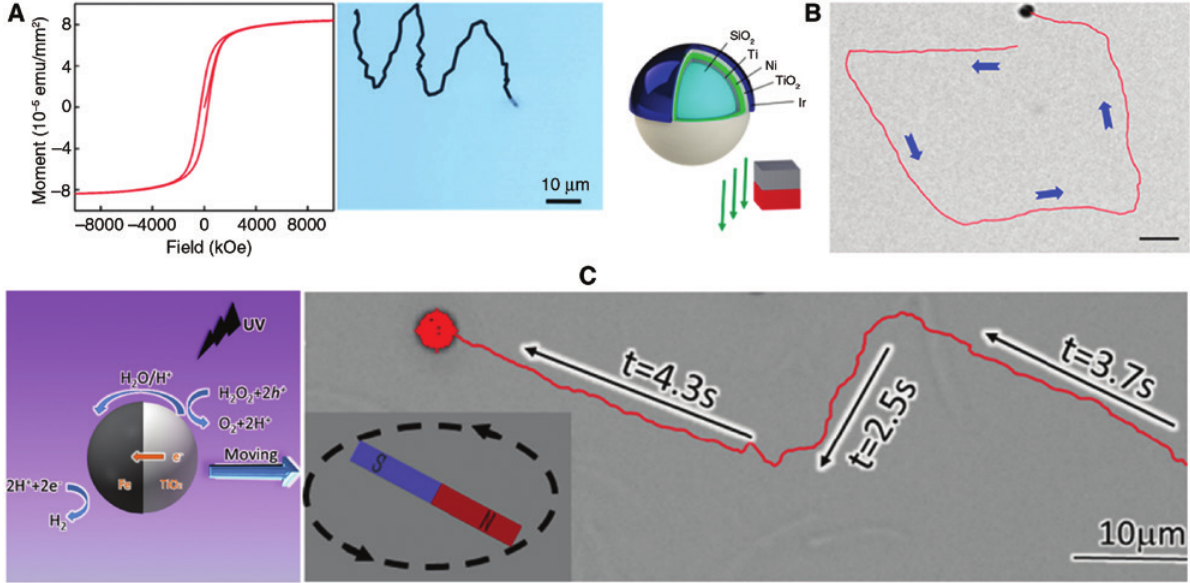
O micromotor and its motion trajectory in 2.5 V% 2 3